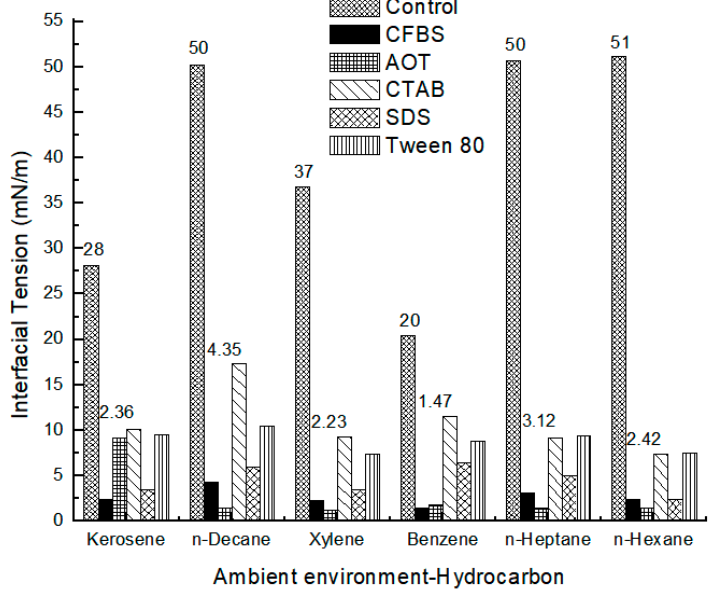
Figure 3. Measurement of interfacial tension (IFT) mN/m for biosurfactant obtained from L. acidophilus NCIM 2903 and synthetic surfactants against water insoluble liquids. Control: Phosphate buffer saline; CFBS: Cell free biosurfactant; AOT: Aerosol OT; CTAB: Cetyl trimethyl ammonium bromide; SDS: Sodium dodecyl sulphate.